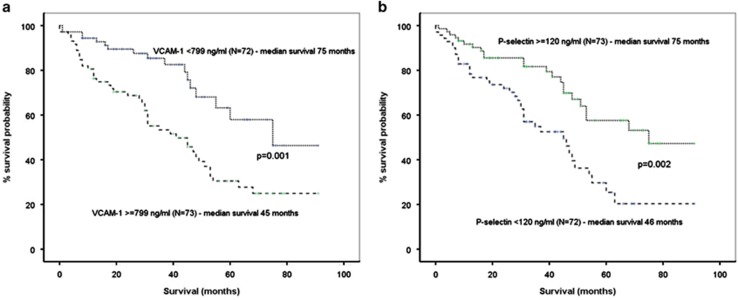
High levels of VCAM and low levels of P-selectin correlate with shorter survival: patients with VCAM levels above median value had a median OS of 45 months in comparison with 75 months of all others (P=0.001; a), while patients with low P-selectin (below median) had a median OS of 46 months compared with 75 months of all others (P=0.002; b).